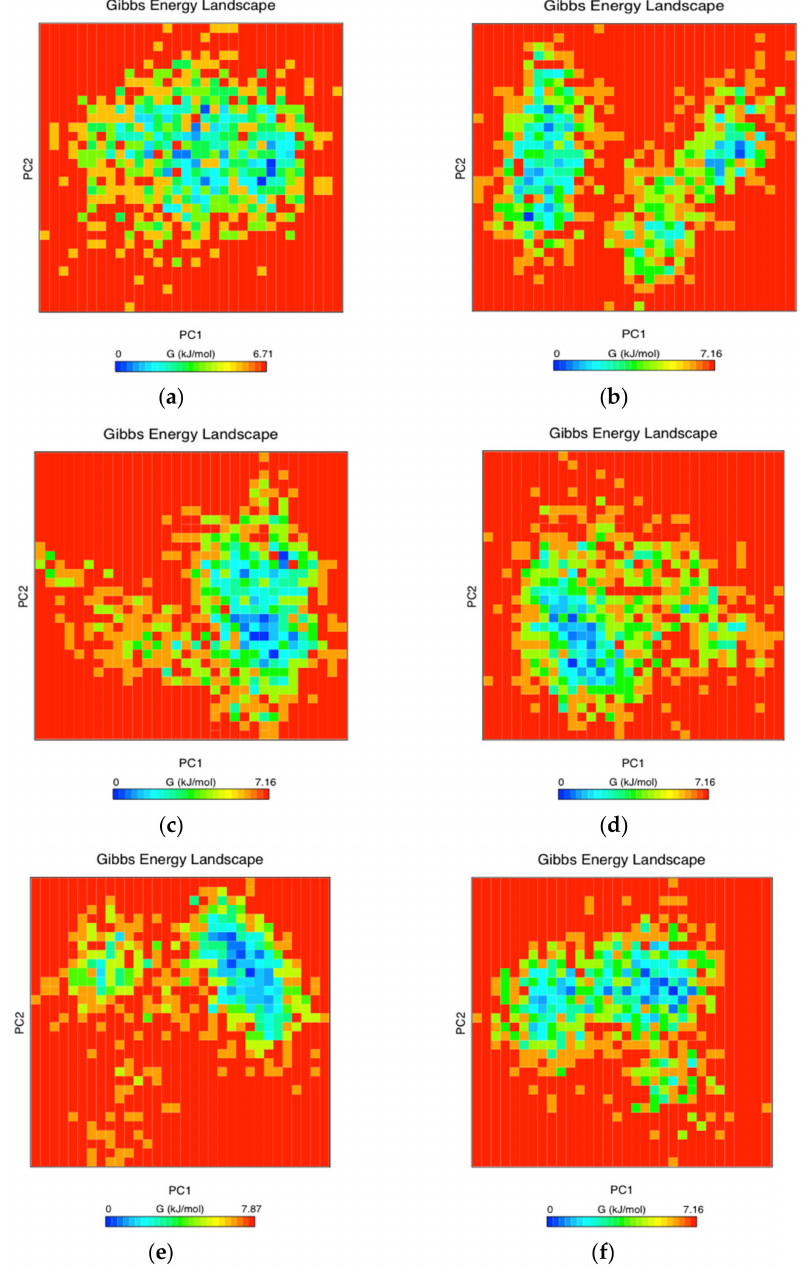
Figure 7. The free energy landscape (FEL) was obtained during the 100-ns MD simulations for each RBD system: WT RBD ( a ), N501Y ( b ), L452R ( c ), S477N ( d ), N439K ( e ), or E484K ( f )